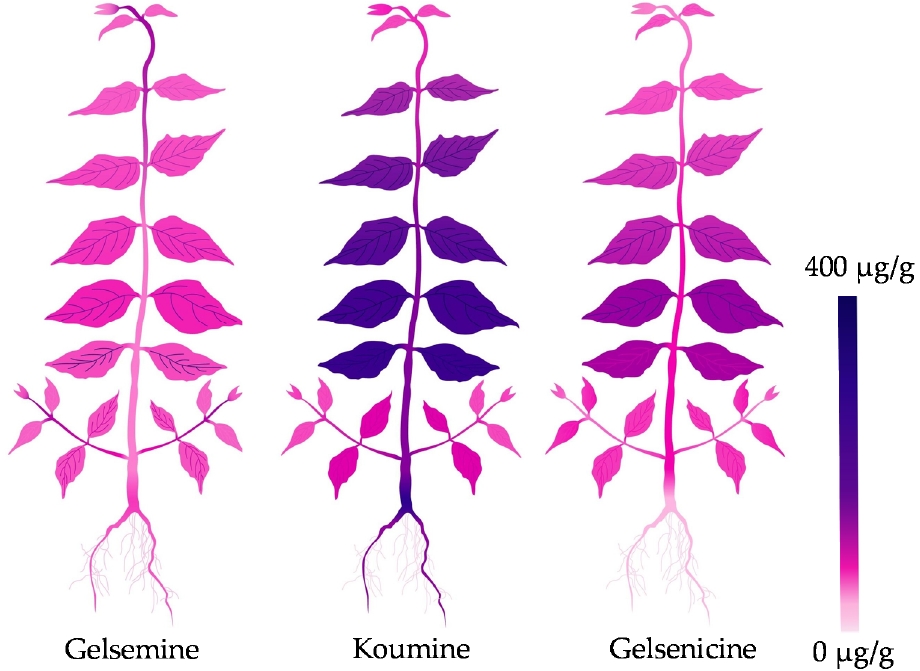
Figure 5. Diagrammatic distribution of three alkaloids in G. elegans .